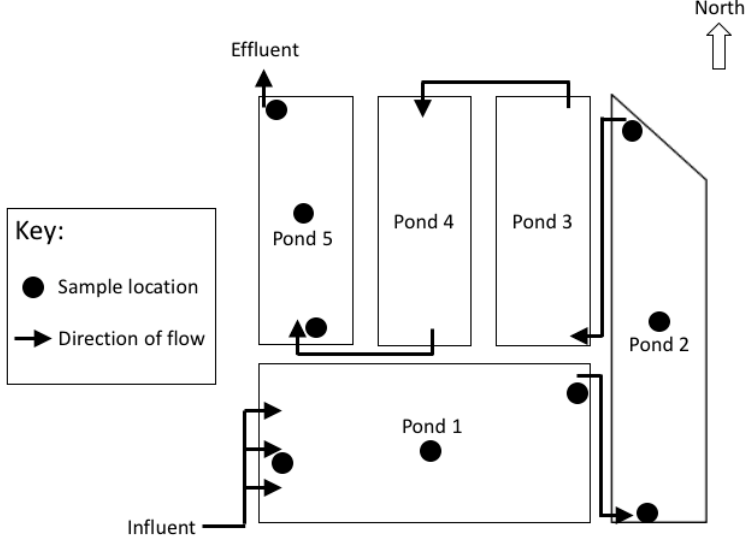
Figure 1. Pond schematic showing the sampling locations in facultative (Pond 1), first maturation (Pond 2) and fourth maturation (Pond 5) ponds of the Sanderson waste stabilization ponds (WSP) system. Estimated hydraulic retention times for each pond are: 10 days (Pond 1); 7 days (Pond 2); and 1.5 days (Pond